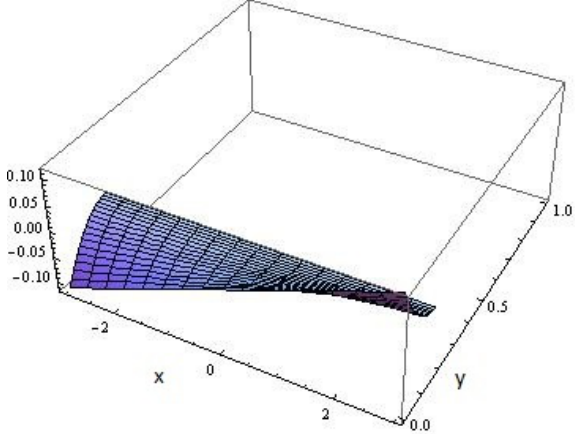
Figure 2. The flow component F θ of the free energy as a function of the vacuum parameter x : = θ and temperature y : = T , describing fluctuations of the YM vacuum ensemble for a given anomaly factor c , decoherence temperature d , and critical exponent e .